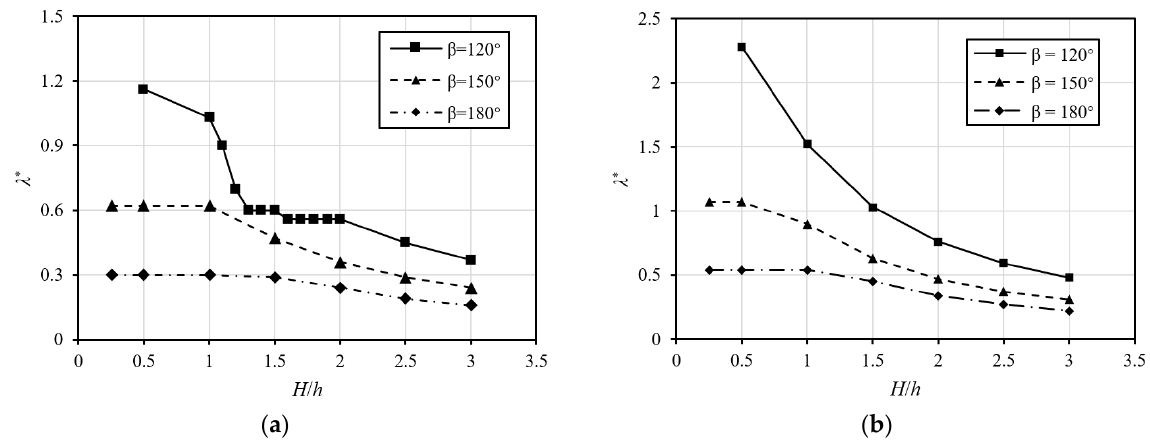
Figure 17. Variation of λ * against H / h : ( a ) circular arch; ( b ) basket-handle arch.